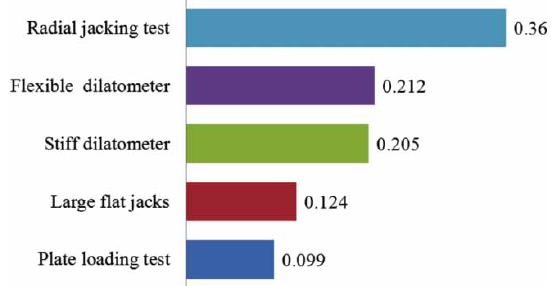
Fig. 7. Ranking list of field tests used in determining rock mass